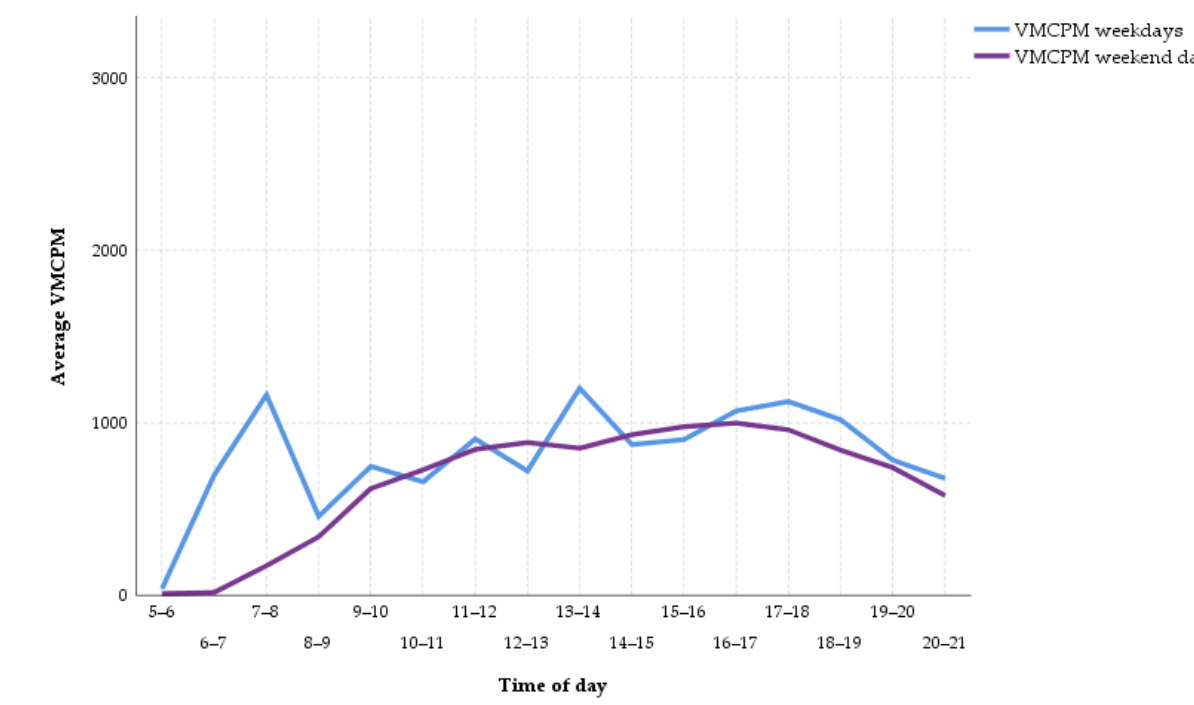
Figure 3. Vector magnitude counts per minute (VMCPM) pattern on weekdays and weekend days.